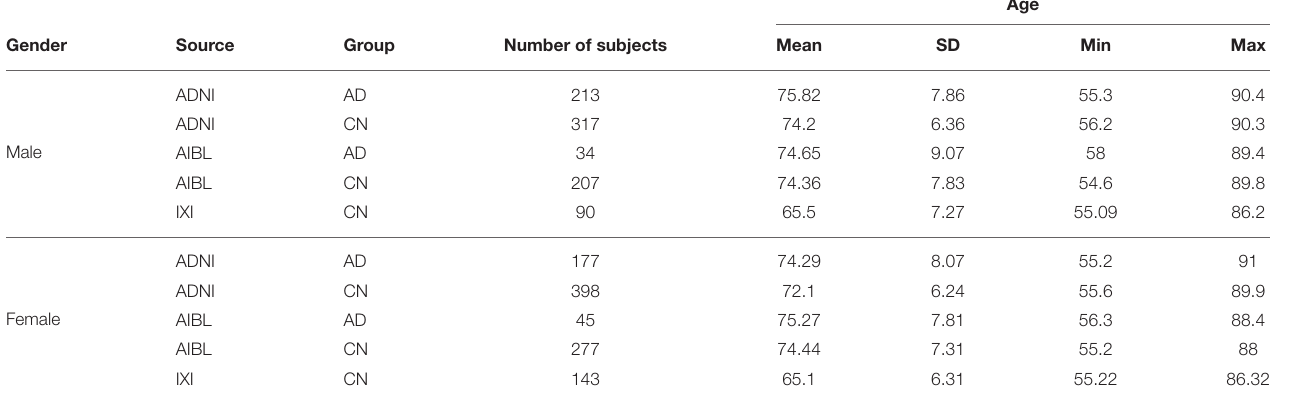
TABLE 1 | Distribution of the 1,901 subjects adopted in this